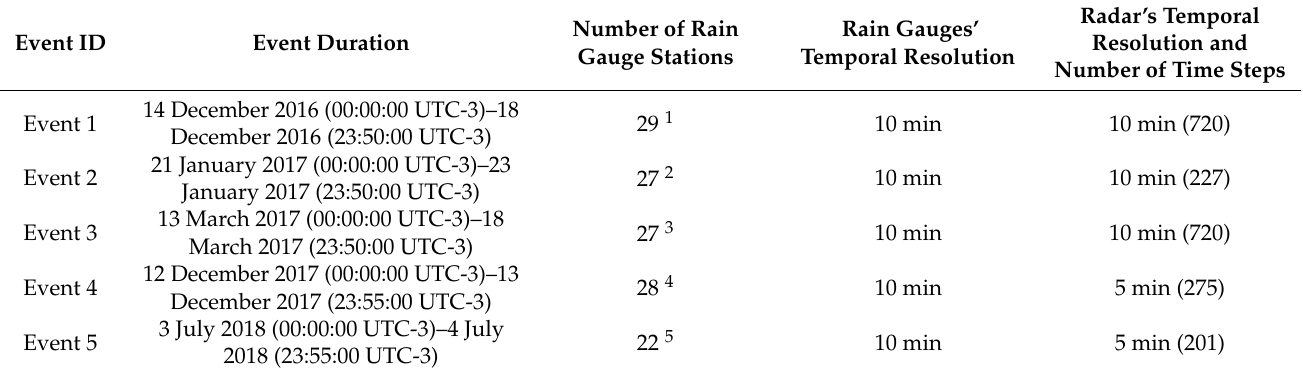
Table 3. Rainfall events, the number of rain gauges used in each event, the rain gauges’ and radar’s temporal resolutions, and the number of radar time steps per